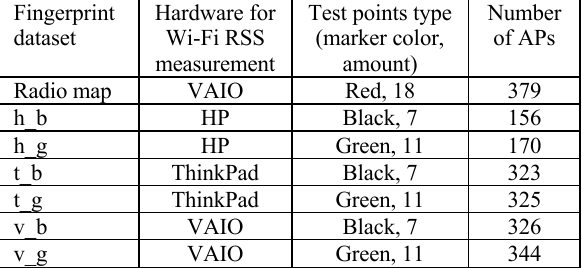
Table 3. Number of APs in different Wi-Fi fingerprint dataset. The first row is the training dataset (radio map), and the rest are the test datasets.